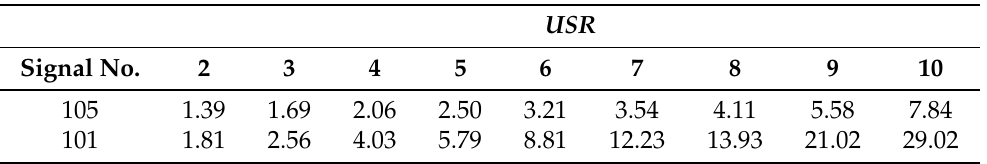
Table 12. Lowest and highest PRD values obtained by the M-OMP algorithm with Ψ α 2 among the considered signals vs. USR